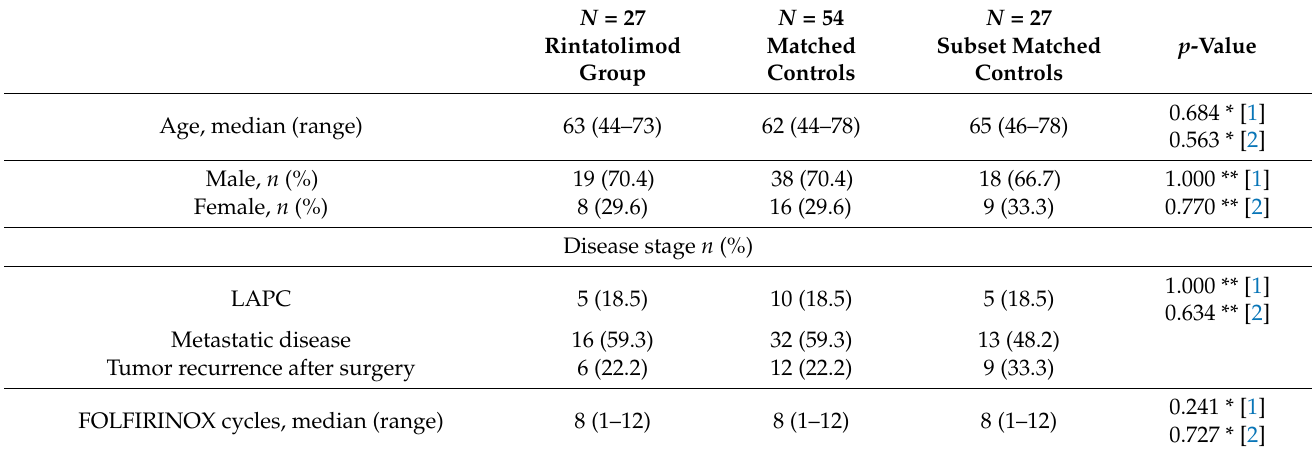
Table 2. Patient